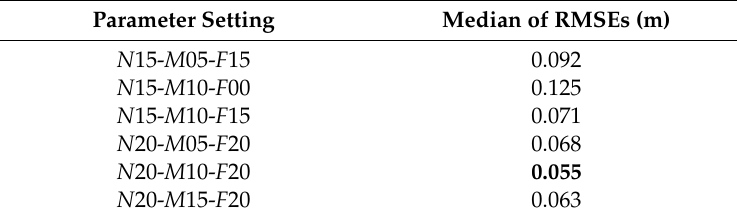
Table 1. The RMSEs of keyframe trajectory error with changing N , M,